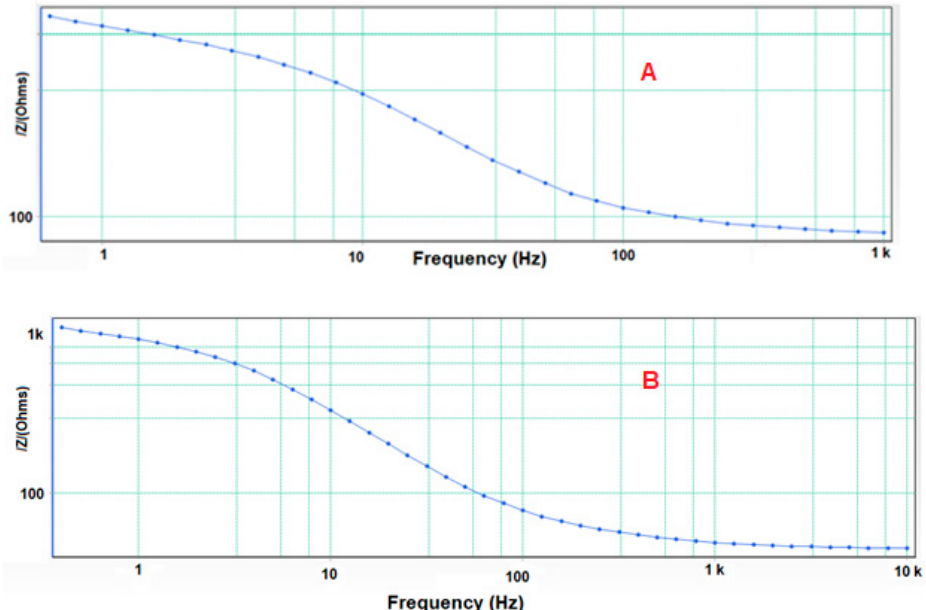
Figure 7. Bode’s plot of impedance vs. frequency for Monel coated with GQD for 45 h. ( A ) First measurement; ( B ) subsequent measurement.